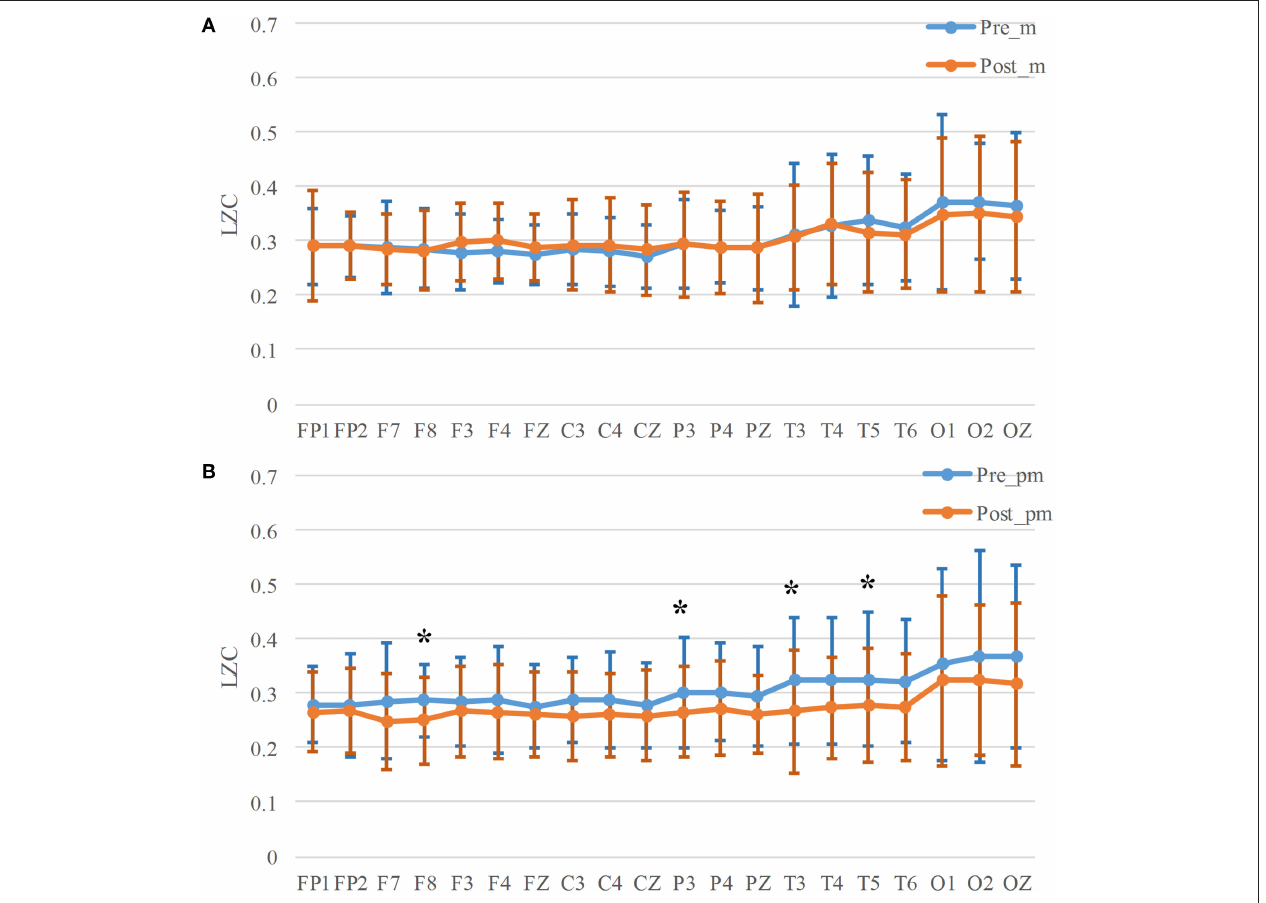
FIGURE 6 | LZC for mental (A) and physical mental tasks (B). * p < 0.05.